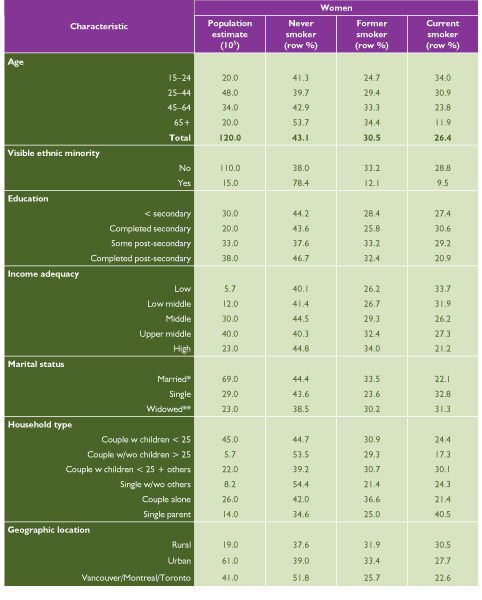
Socio-demographic Characteristics of Never Smokers, Former Smokers and Current Smokers: Women (NPHS 1998–1999)